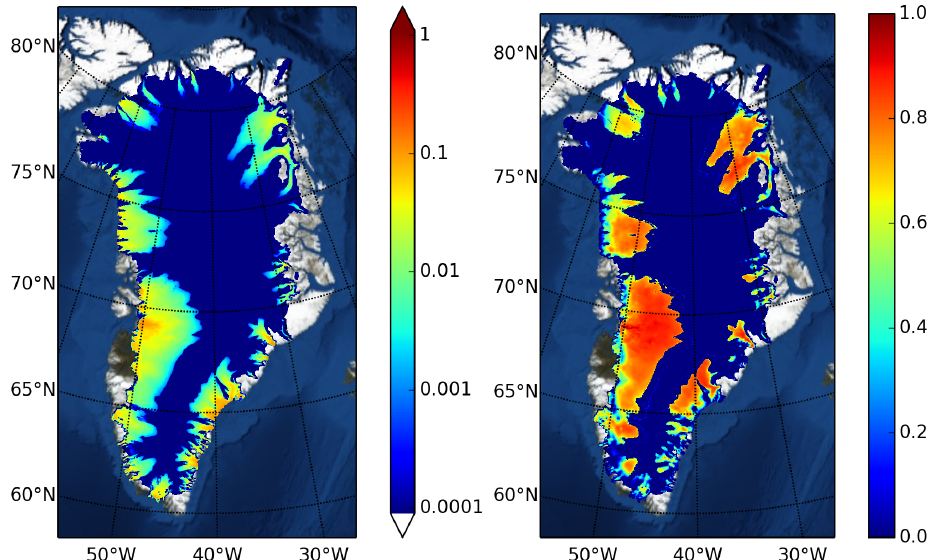
Figure 9. Outputs from the distributed hydrology model include the modeled transportable water layer thickness W (left; m), and the modeled transportable water layer pressure P , shown relative to overburden pressure (i.e., P/P o ; right).